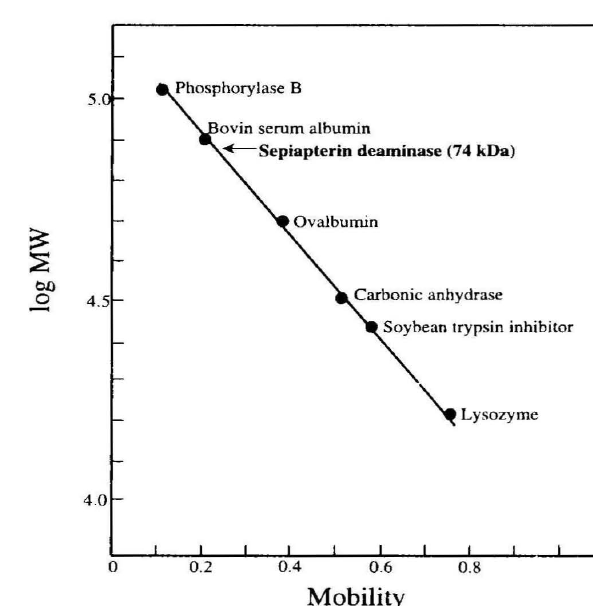
Figure 3. Molecular weight determination of sepiapterin deaminase by SDS-PAGE. The molecurar weight marker proteins were: lysozyme (19 kOa), soybean trypsin in hibitor (28 kDa), carbonic anhydrase (33 kDa), ovalbu min (50 kDa), bovine serum albumin (80 kDa), phos phorylase B (110 kDa). The arrow shows sepiapterin